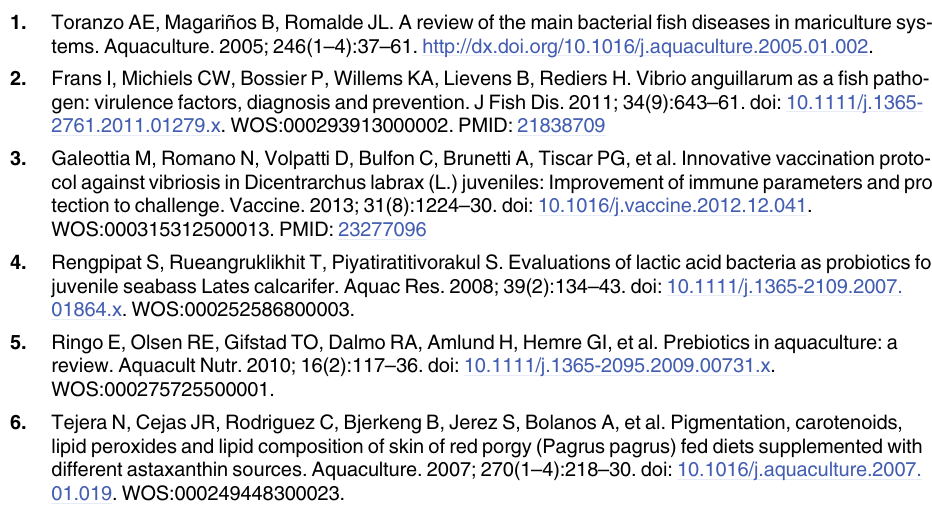
S1 Table. Characteristics of new assembled sequences of European sea bass according to BLAST